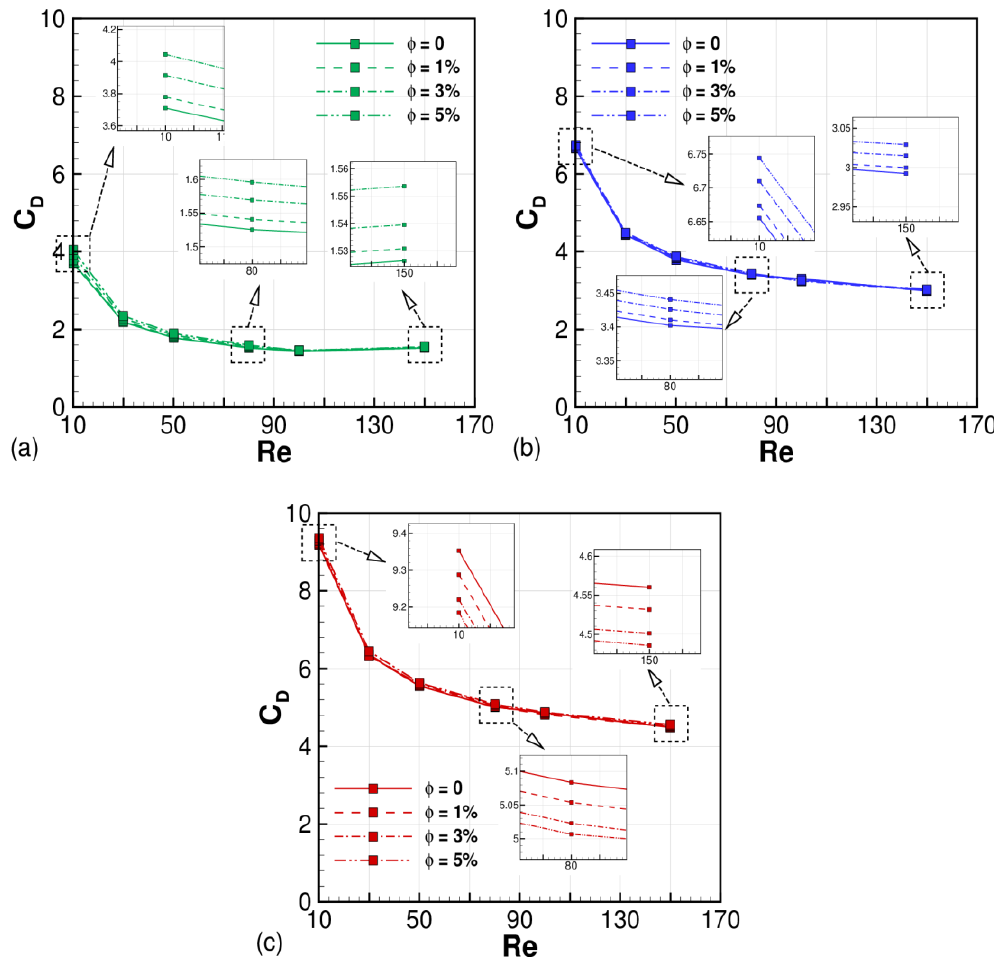
Figure 9. Drag coefficient ( 𝐶 𝐷 ) as a function of Re for different values of φ at Ri ; ( a ) 0, ( b ) 0.5, and ( c ) 1.0.